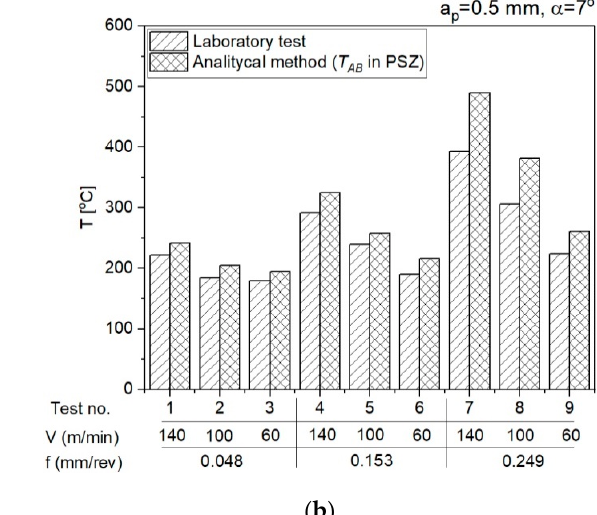
Figure 12. The mean temperature values in the PSZ obtained using the analytical method and the results of measurements with a thermovision camera. ( a ) a p = 1.77 mm, α = 15°; ( b ) a p = 0.5 mm, α = 7°.